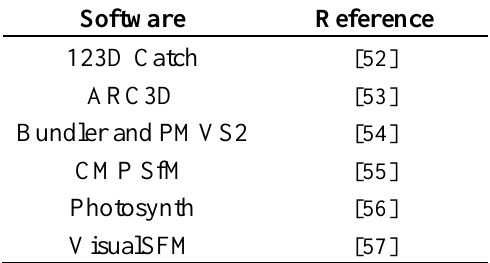
Table 2. Free available software to generate 3D models using conventional